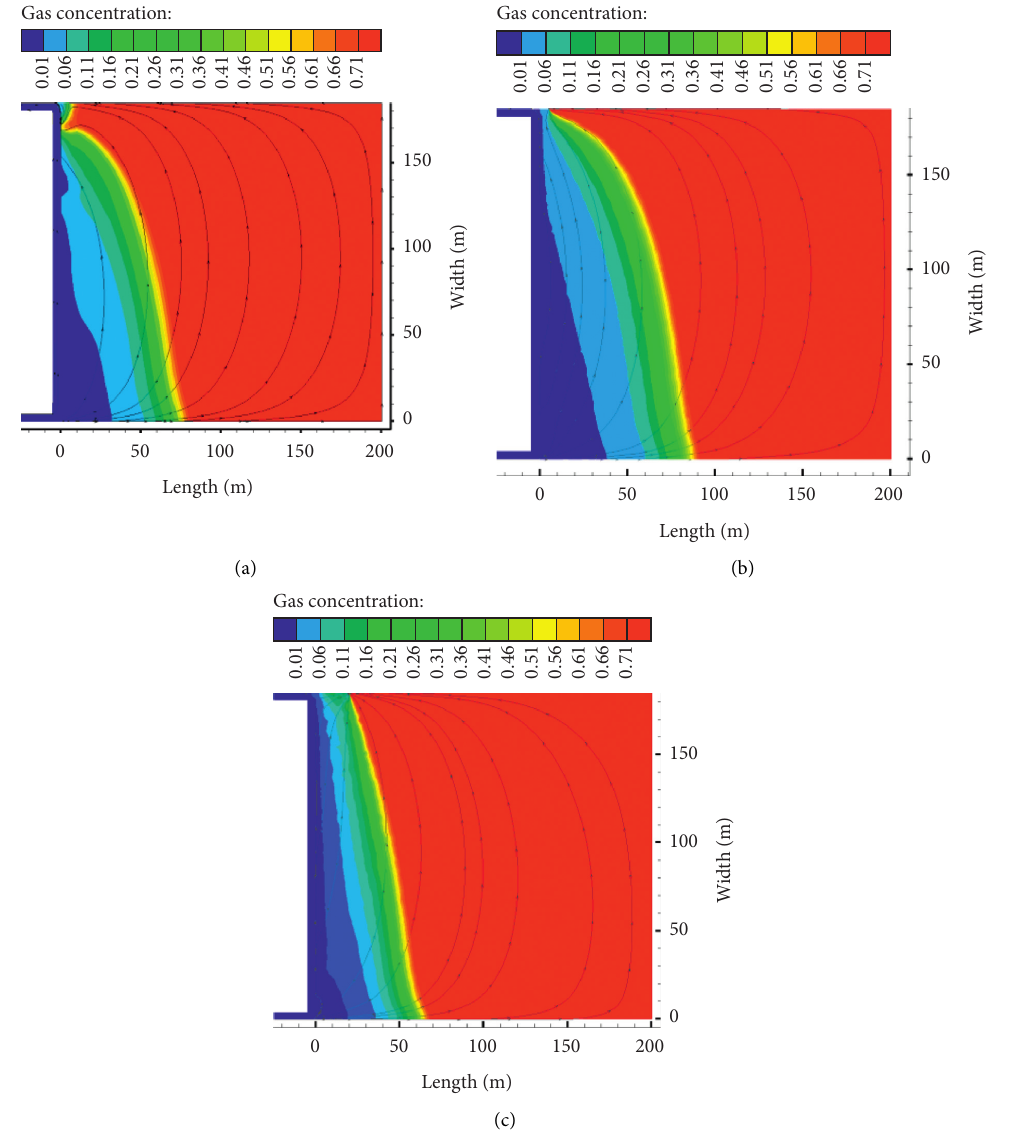
Figure 5: Gas distribution in goaf under different parameters. (a) Gas distribution in goaf without drainage. (b) Gas distribution under the condition of drainage ( x � 10m, v � 3m · s − 1 ). (c) Gas distribution in goaf without drainage ( x � 20m, v � 5m · s − 1